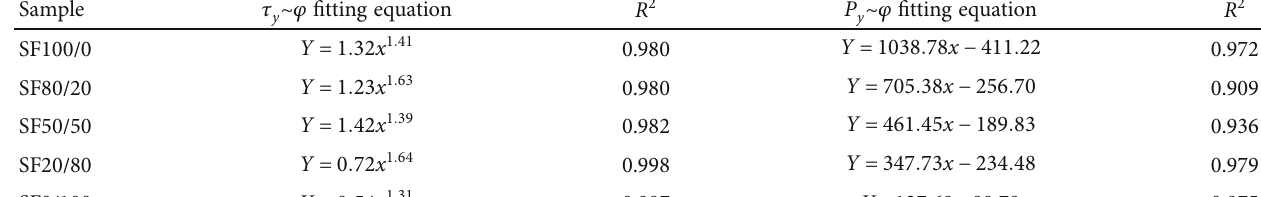
Table 3: Fitting statistics of the yield stress of aramid fi ber suspensions with various fi ber/ fi brid ratios. Sample